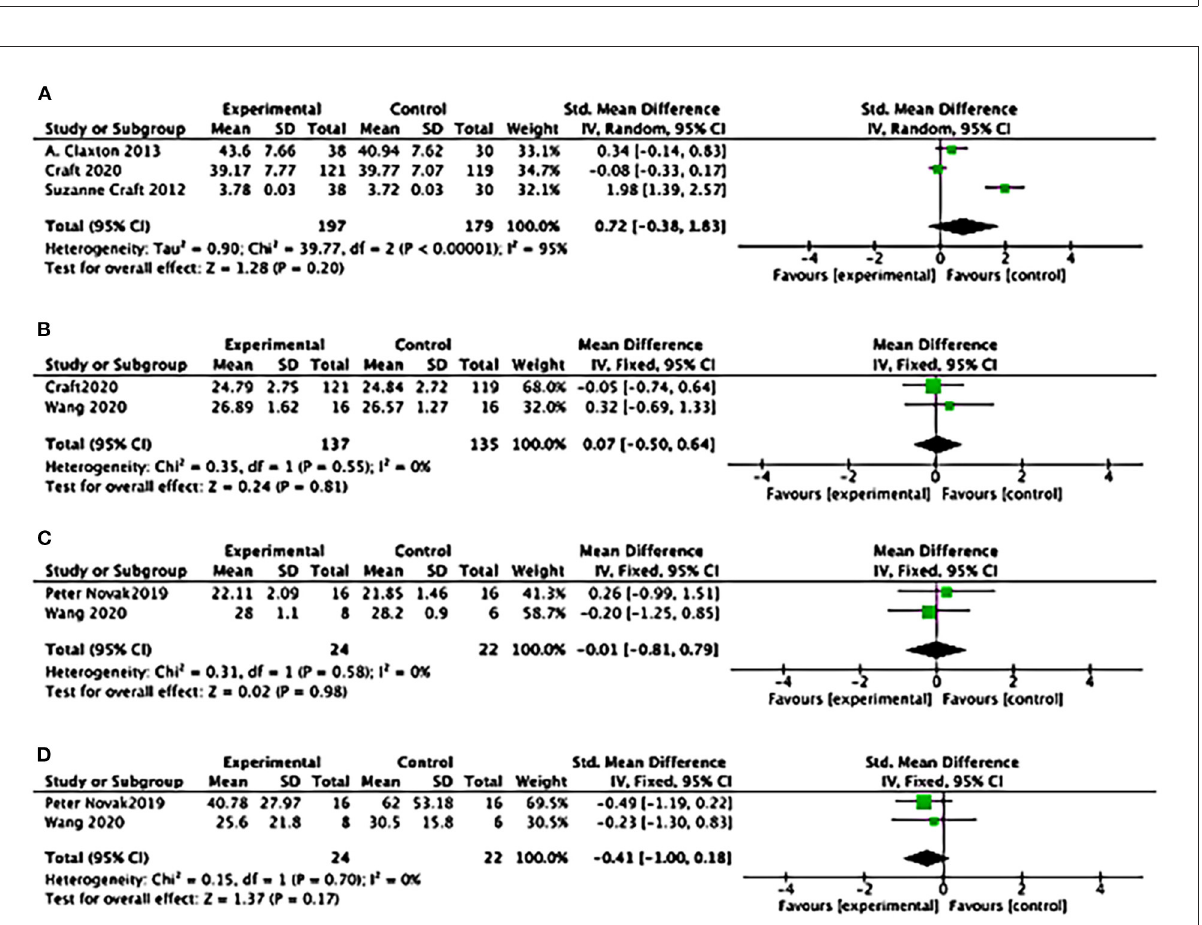
FIGURE7 Forest plot for the effects of cognitive performance. (A) Forest plot for the effects of the Alzheimer’s Disease Cooperative Study–activities of daily living Statistical (ADCS-ADL ): results suggested a difference between study groups: (3 studies): SMD = 0.26, 95% CI = 0.05 to 0.47; P = 0.01); (B) Forest plot for the effects of Mini-mental Atate Examination (MMSE): SMD favoured Insulin but not statistically different of the effects (2 studies): SMD = 0.07, 95% CI = − 0.50 to 0.64; P = 0.81; (C) Forest plot for the effects of Montreal Cognitive Assessment (MoCA): No differences